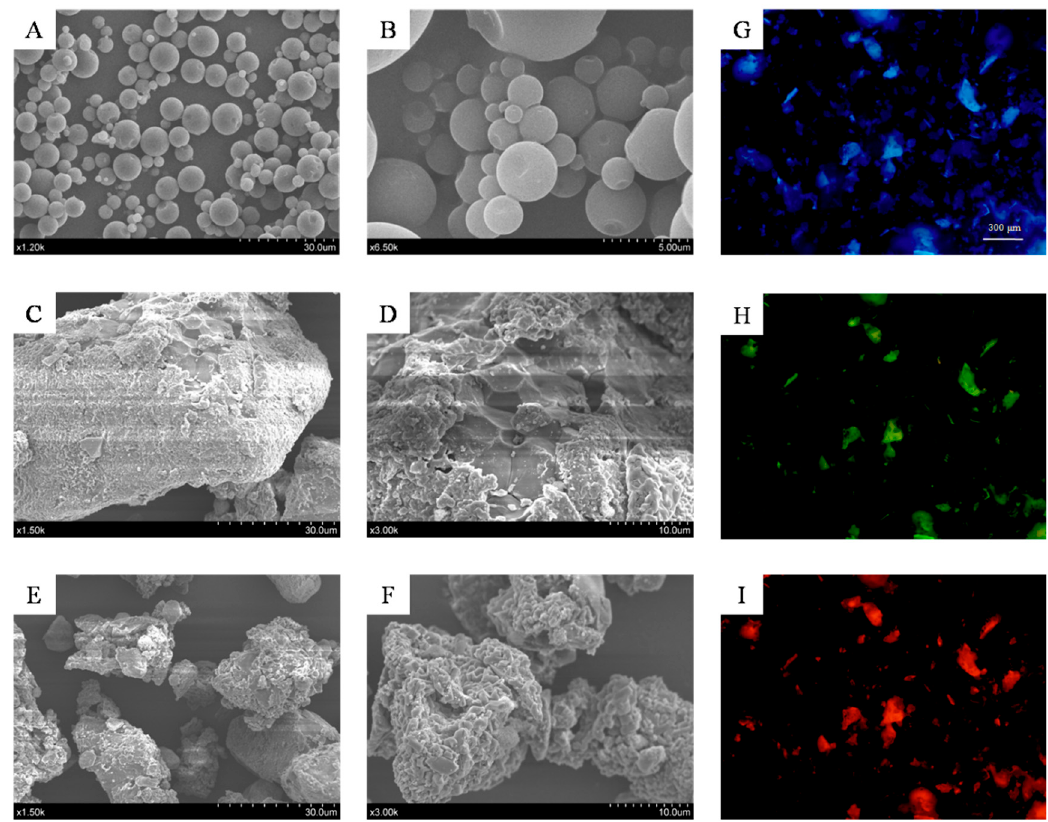
Figure 1. Scanning electron microscopy (SEM) images and fluorescence micrographs of the ultra-micro kiwifruit powder (UKP). SEM: A – B , SEM images of microencapsulation at 1.2 k and 6.5 k × magnification, respectively; C – D , SEM images of insoluble dietary fiber (IDF) before the grinding process at 1.5 k and 3.0 k × magnification, respectively; E – F , SEM images of IDF after the grinding process at 1.5 k and 3.0 k × magnification, respectively. Fluorescence micrographs: images of IDF after the grinding process were obtained by UV argon ion laser; the blue fluorescence ( G ), the green fluorescence ( H ) and the red fluorescence ( I ).